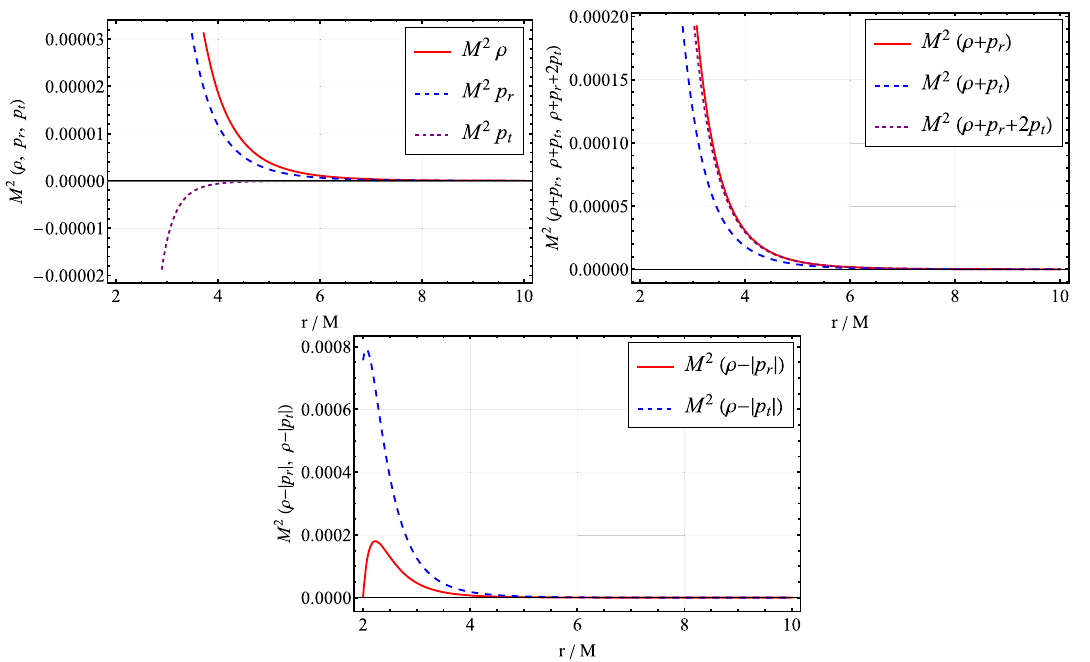
Fig. 2 Matter components ρ , p r and p t (left panel), combinations ρ + p ρ + p ρ + p + 2 p r , t , and r t (right panel) and combinations ρ − | p | and ρ − | p | (middle panel) as functions of the normalized r r radial coordinate r / M with α = 5, β = 4, λ = − 100 π , r 0 = 2 M ,